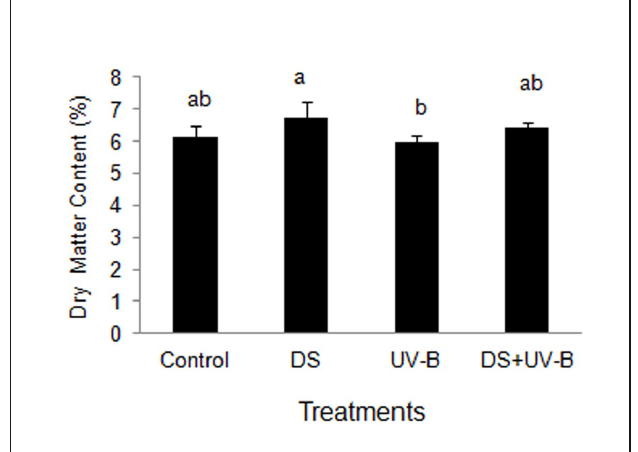
Fig. 2: Dry matter content (%) of lettuce at harvest in response to drought stress, UV-B radiation and the combination of drought stress and UV-B radiation. Vertical bars represent standard deviation, and different letters indicate differences at the significance level p ≤ 0.05 (Tukey test). (Control = well-watered; DS = drought stress, i.e. water-deficit; UV-B = well-watered with UV-B radiation of 0.11 kJ m -2 ; DS+UV-B = drought stress i.e. water-deficit in combi- nation with